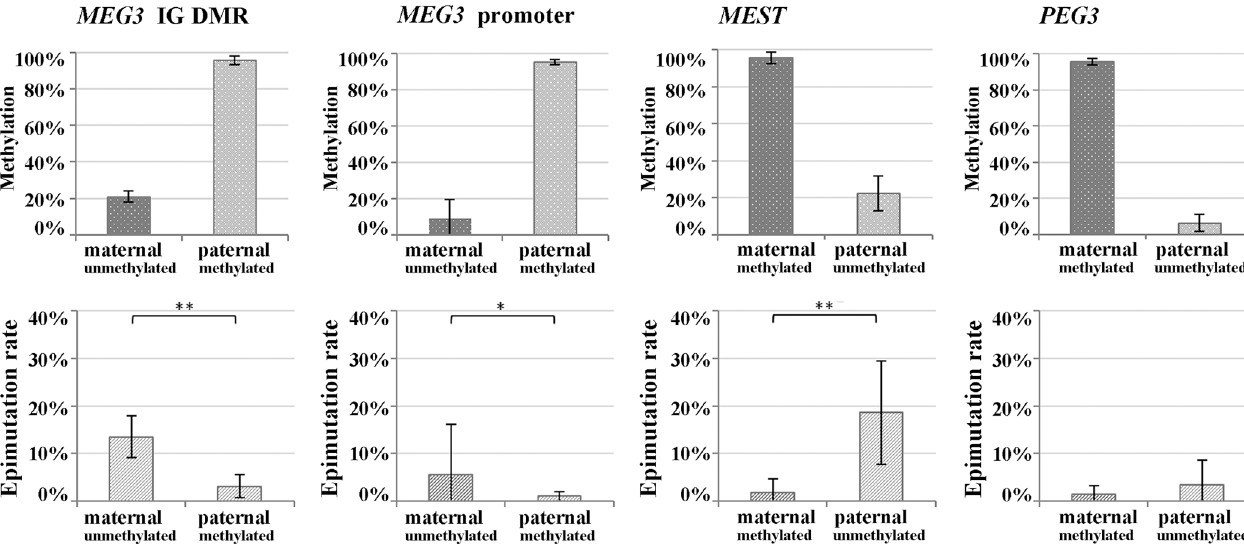
Fig 4. Mean FCB methylation and epimutation rates of maternal versus paternal alleles of the MEG3 IG DMR, MEG3 promoter, MEST , and PEG3 . DBS was performed with the Illumina MiSeq. The non-imprinted alleleof MEG3 (both primary and secondary DMR) and MEST exhibited significantly higherepimutation rates than the